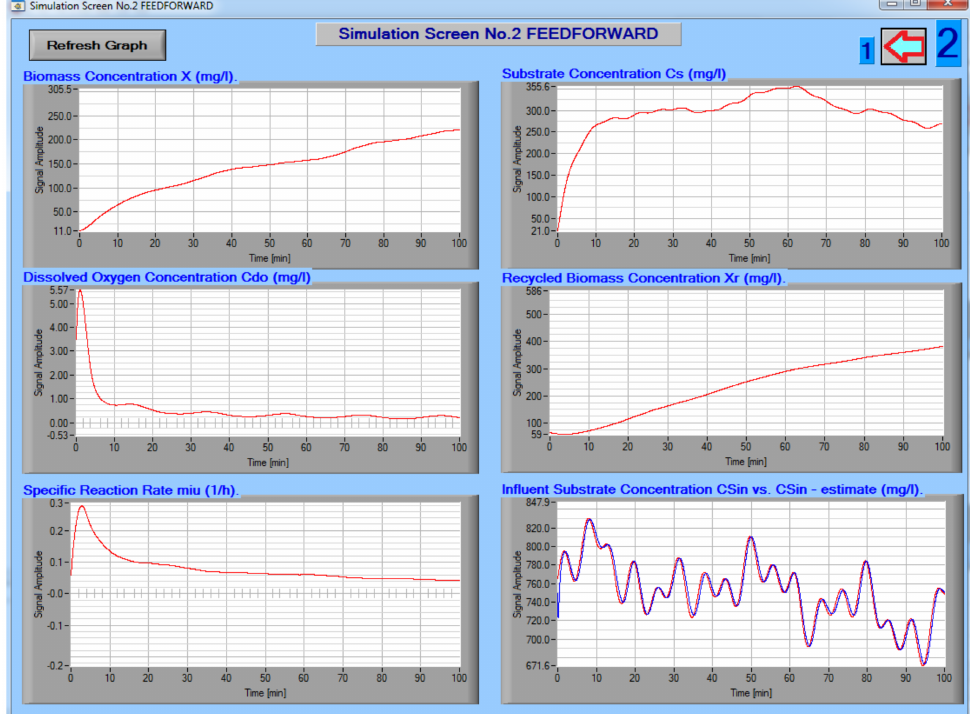
Figure 7. Open-loop simulation of the ASP, the biological treatment stage, with the visualization of the evolution of the main biological variables (the second